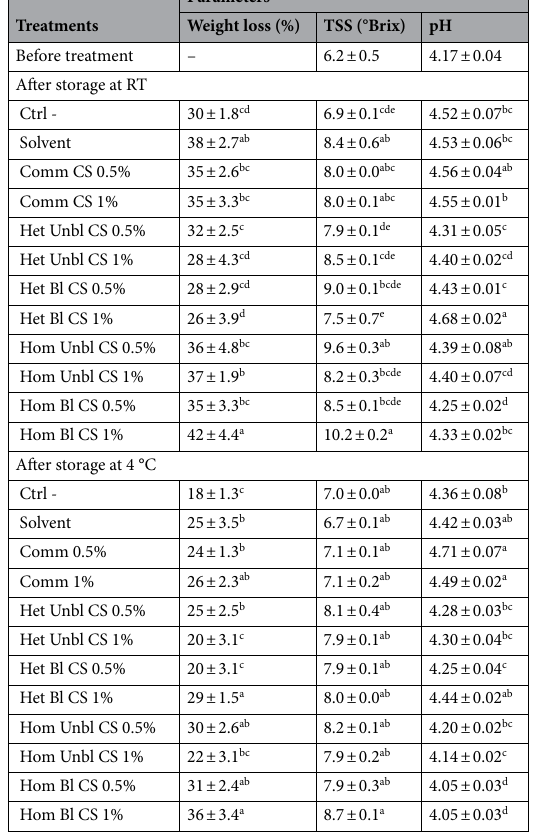
Table 2. Results of evaluation of weight loss, total soluble solids (TSS) and pH on whole tomatoes, coated by dipping, after 30 days of storage at room temperature (RT) and 4 °C. Treatments: untreated fruits (Ctrl -), solvent only, coating with heterogeneous unbleached (Het Unbl CS), heterogeneous bleached (Het Bl CS), homogeneous unbleached (Hom Unbl CS), homogeneous bleached (Hom Bl CS) and commercial (Comm CS) chitosan. Means followed by different letters in the column are significantly different by Mann–Whitney U test (p < 0.05). Each trial contained three triplicates of whole tomatoes per each treatment. Asterisks